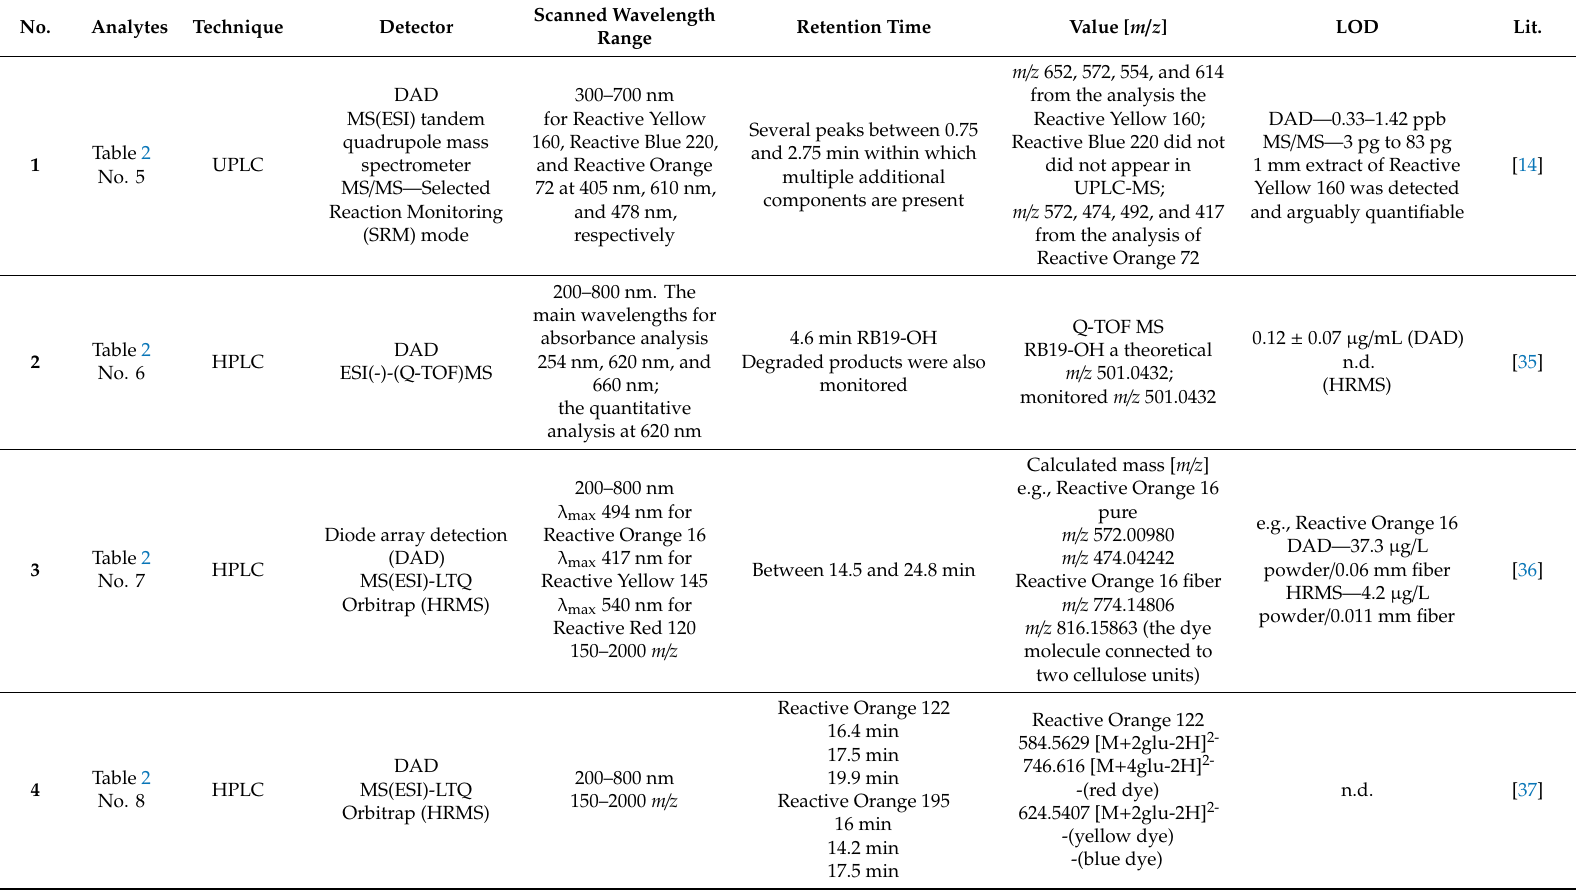
Table 4. Overview of chromatographic methods described in the literature for the identification of reactive dyes extracted from cotton fibers (selected qualification and quantification